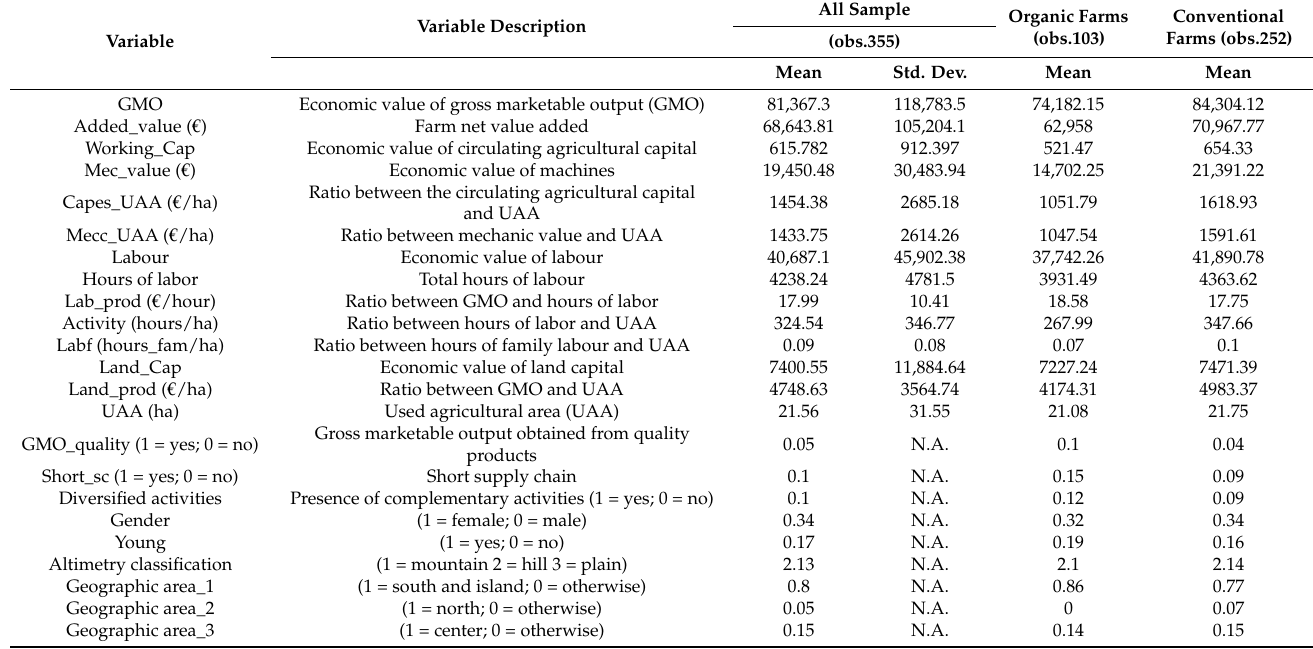
Table 2. Descriptive statistics of variables for organic and conventional